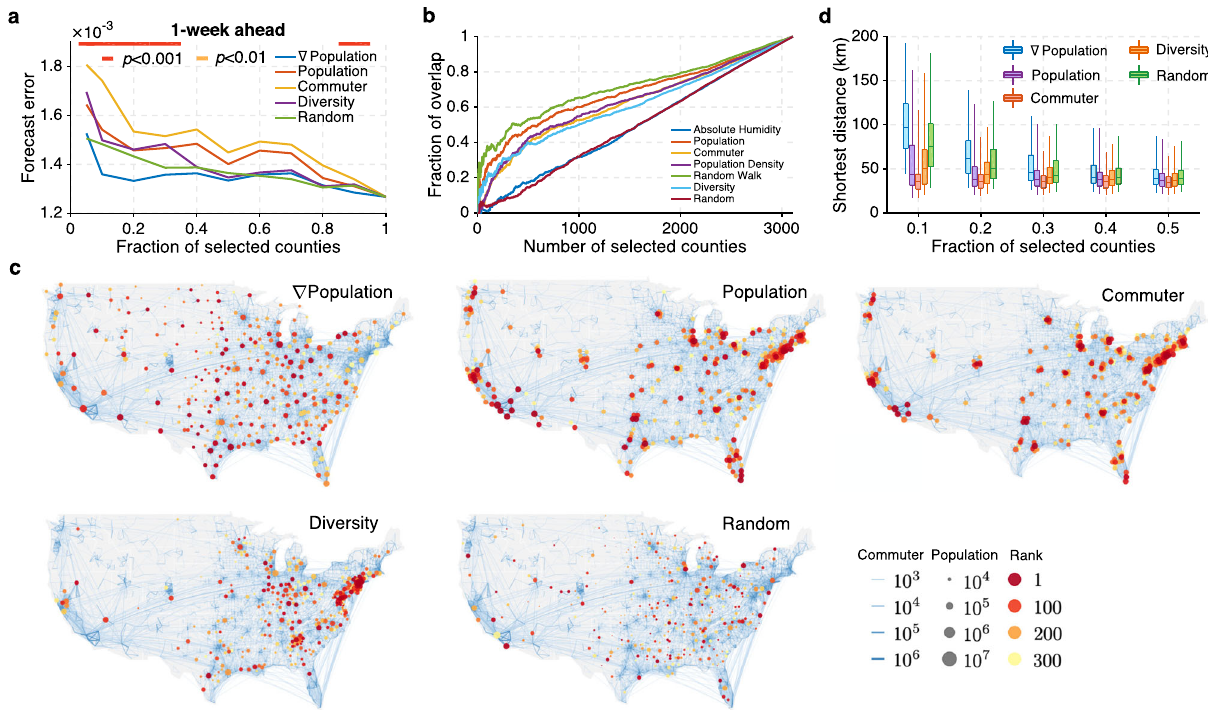
Fig. 4 Surveillance networks at the county level. a Forecast error for 1-week ahead ILI + predictions using surveillance networks consisting of 5%, 10%, 20% up to 100% of all counties. Networks are selected by population gradient ( ∇ Population) (blue line), population (red line), commuter (orange line), diversity of commuters ’ residential locations (purple line), and random selection (green line). The statistical signi fi cance for population gradient outperforming all other methods is reported using the horizontal bars on top (two-sided Wilcoxon signed-rank test; red: p < 0.001, orange: p < 0.01, none: p ≥ 0.01). b Overlap between the counties selected by ∇ Population and those selected by other attributes: absolute humidity (blue line), population (red line), commuter (orange line), population density (purple line), random walk centrality (green line), diversity of commuters ’ residential locations (light blue line), and random selection (dark red line). c Visualization of surveillance networks consisting of 10% of all counties selected by population gradient, population, commuter numbers, commuter diversity and random selection. Blue curves on the map represent county-to-county commuting. Node color indicates the ranking using different methods, and node size re fl ects the population size. d Comparison of the distributions of distance between nearest neighbors within surveillance networks designed using different strategies: ∇ Population (blue), population (purple), commuter (red), diversity of commuters ’ residential locations (orange), and random selection (green). Boxes show the median and interquartile, and whiskers show 95% CI. Distributions were obtained from n = 310, 621, 932, 1243, and 1554 counties, respectively, corresponding to 10%, 20%, 30%, 40, and 50% of all